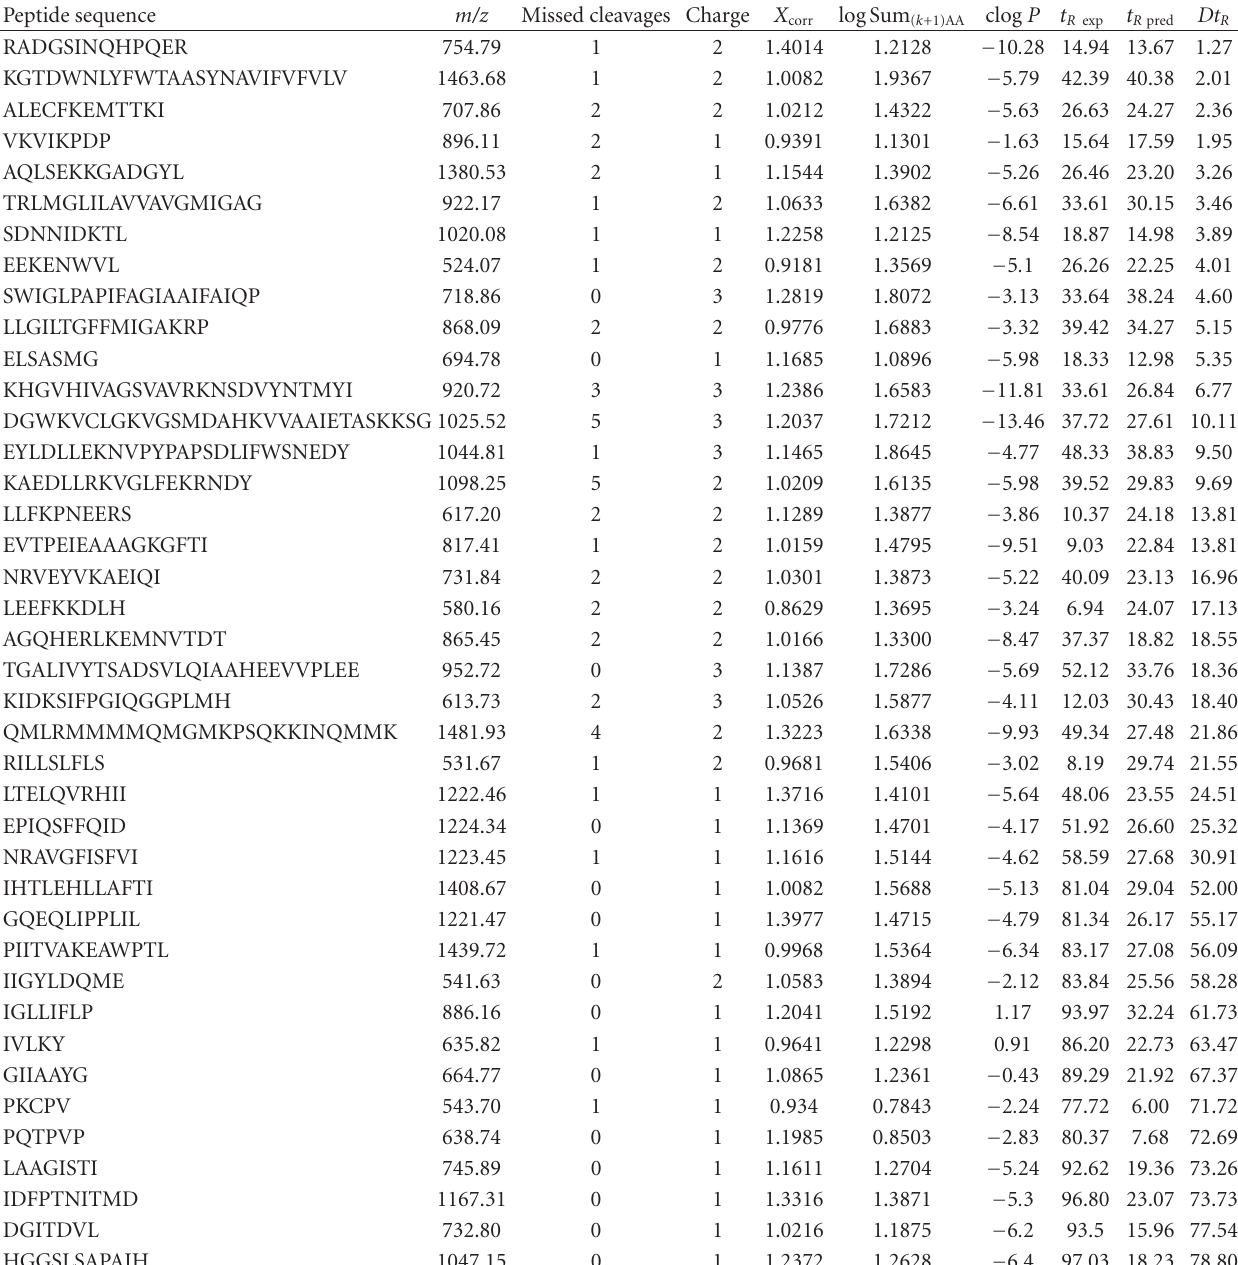
Table 5: Test peptides from proteins of Bacillus subtilis proteome, identified on the basis of one peptide with X corr below 1.5. Peptide